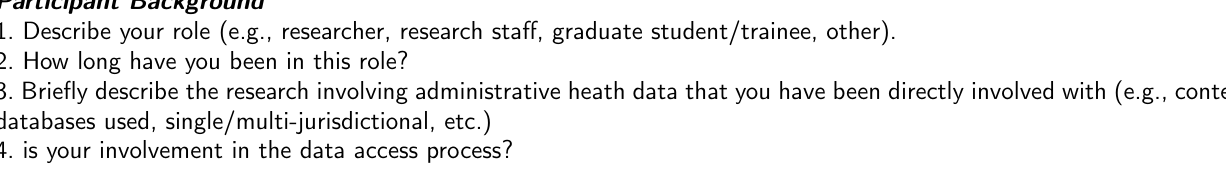
Supplementary table 1: Interview guide for researchers and research